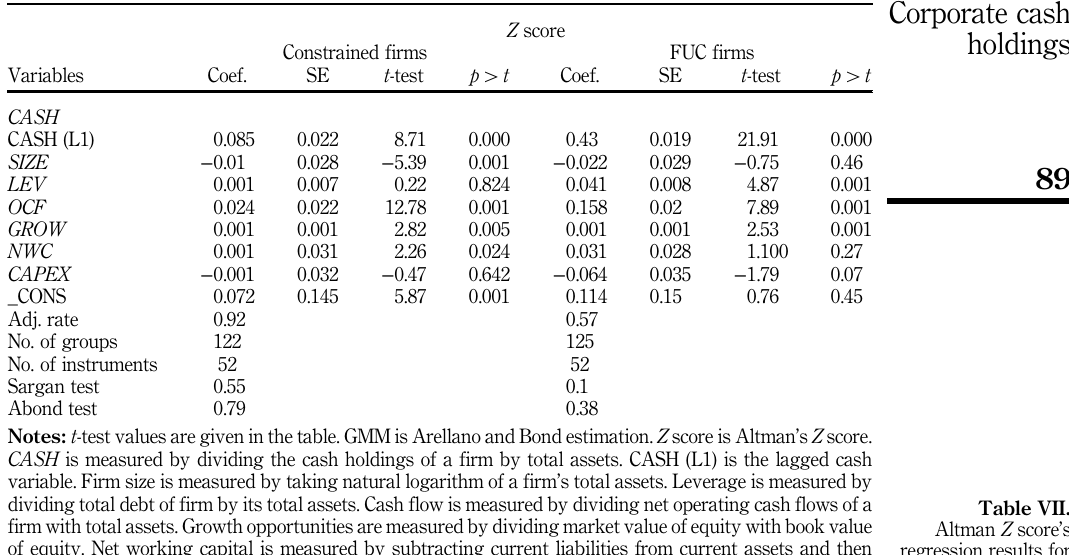
Table VII. Altman Z score ’